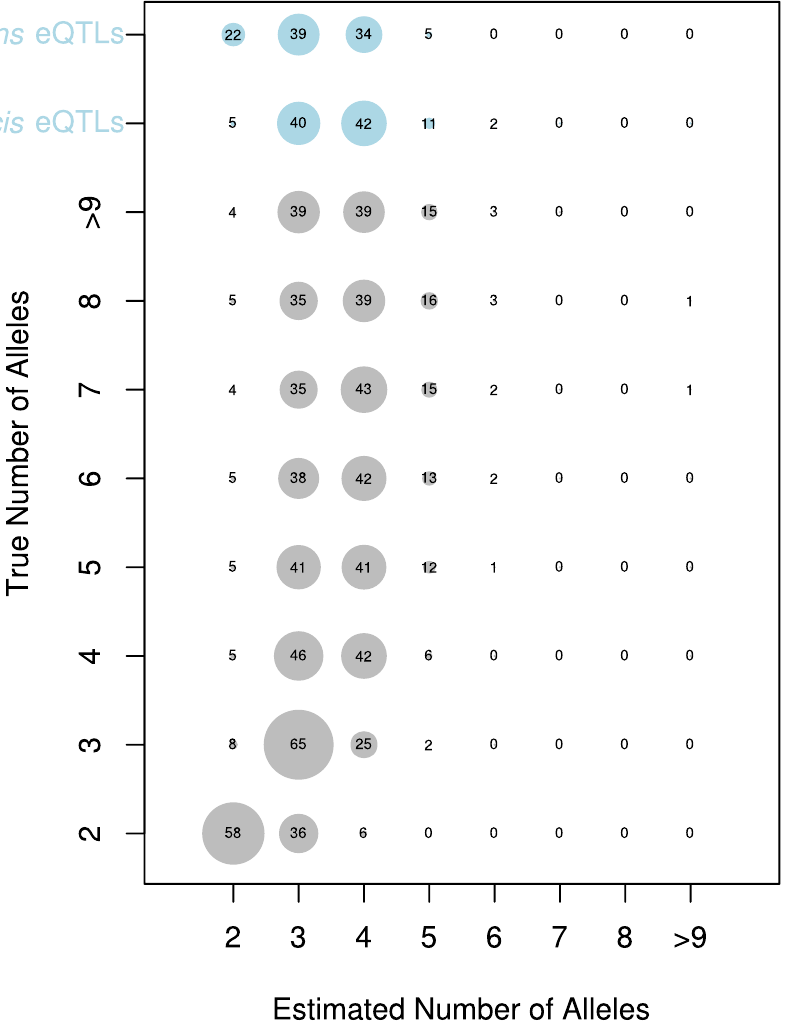
Figure 6. Estimated number of alleles for simulated (grey circles) and observed data (blue circles). The true number of alleles versus the estimated number of alleles is displayed for simulated data. The size of each circle and the number displayed denotes the percentage of times each number of alleles is estimated for a given true number of alleles. The estimated number of alleles for our cis - and trans -eQTL are shown at the top of the